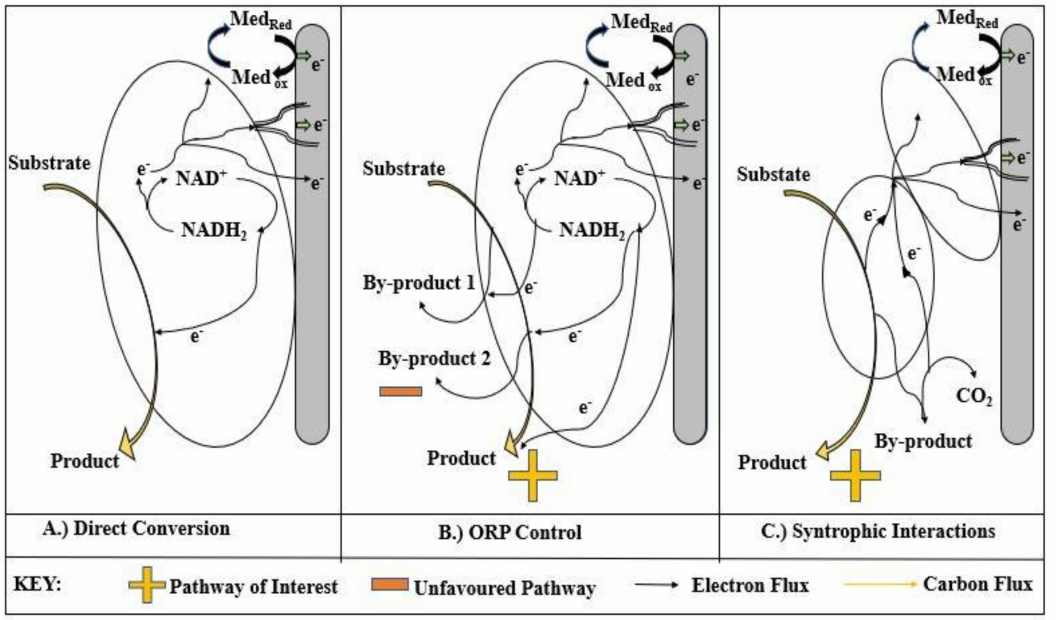
Figure 4. A diagrammatic representation of the possible mechanisms that can occur during anodic electro-fermentation (EF). ( A ) The substrate is directly converted into the product and the excess of electron is fully dissipated at the anode through mechanisms of extracellular electron transfer. ( B ) The electron excess generated during the formation of the oxidized products is not fully dissipated at the anode and a section of the substrate is utilized for this purpose. The electron elimination at the anode leads to the reducing NADH / NAD + ratio resulting in the compensating cellular regulation favoring pathways to regulate NADH. ( C ) The fermentative microorganism (yellow) consumes the substrate but is not able to interact with the anode. The electroactive microorganism (red) acts as a mediator between the fermentative microorganism and the anode through interspecies electron transfer mechanisms